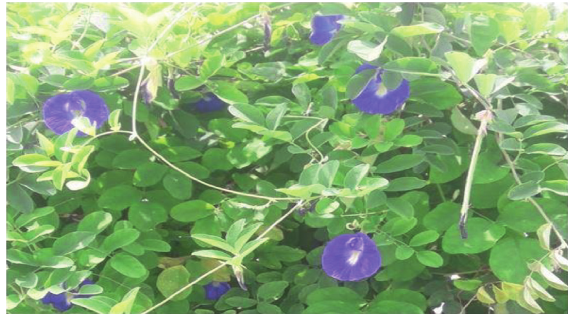
Figure 1: Picture of Clitoria ternatea flower from the